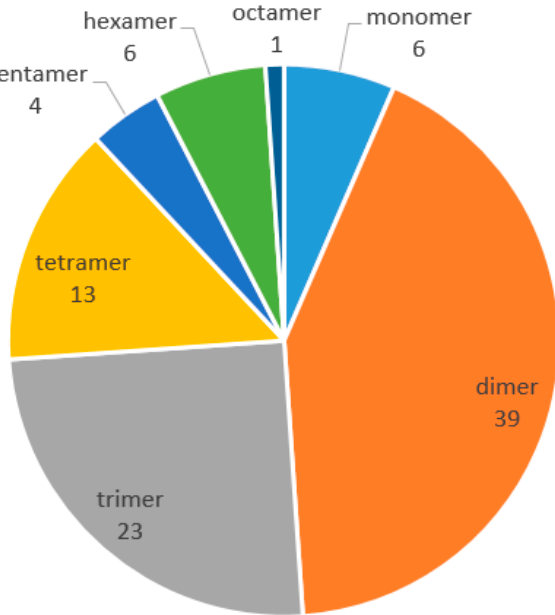
Figure 1. The polymerization situations of resveratrol oligomers from 2010 to 2017.